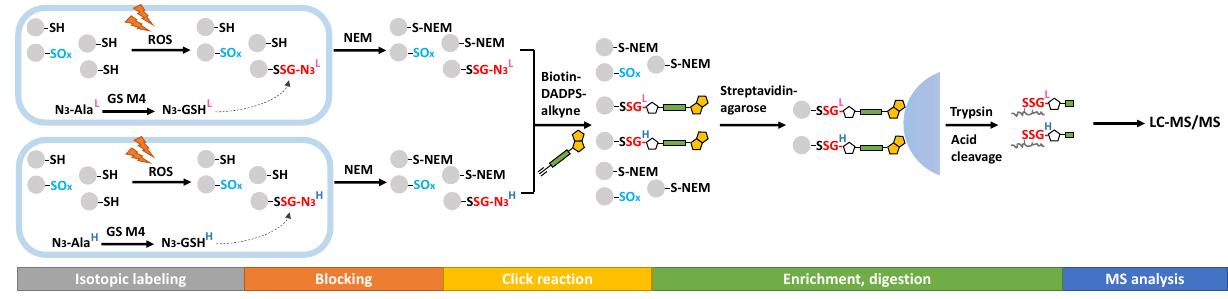
Figure 5. Proteomics approaches for SSG detection using clickable analogs of GSH.